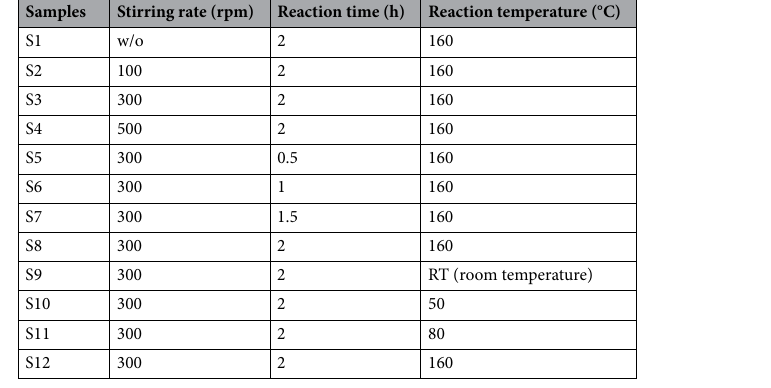
Table 1. Reaction variables used in the synthesis of